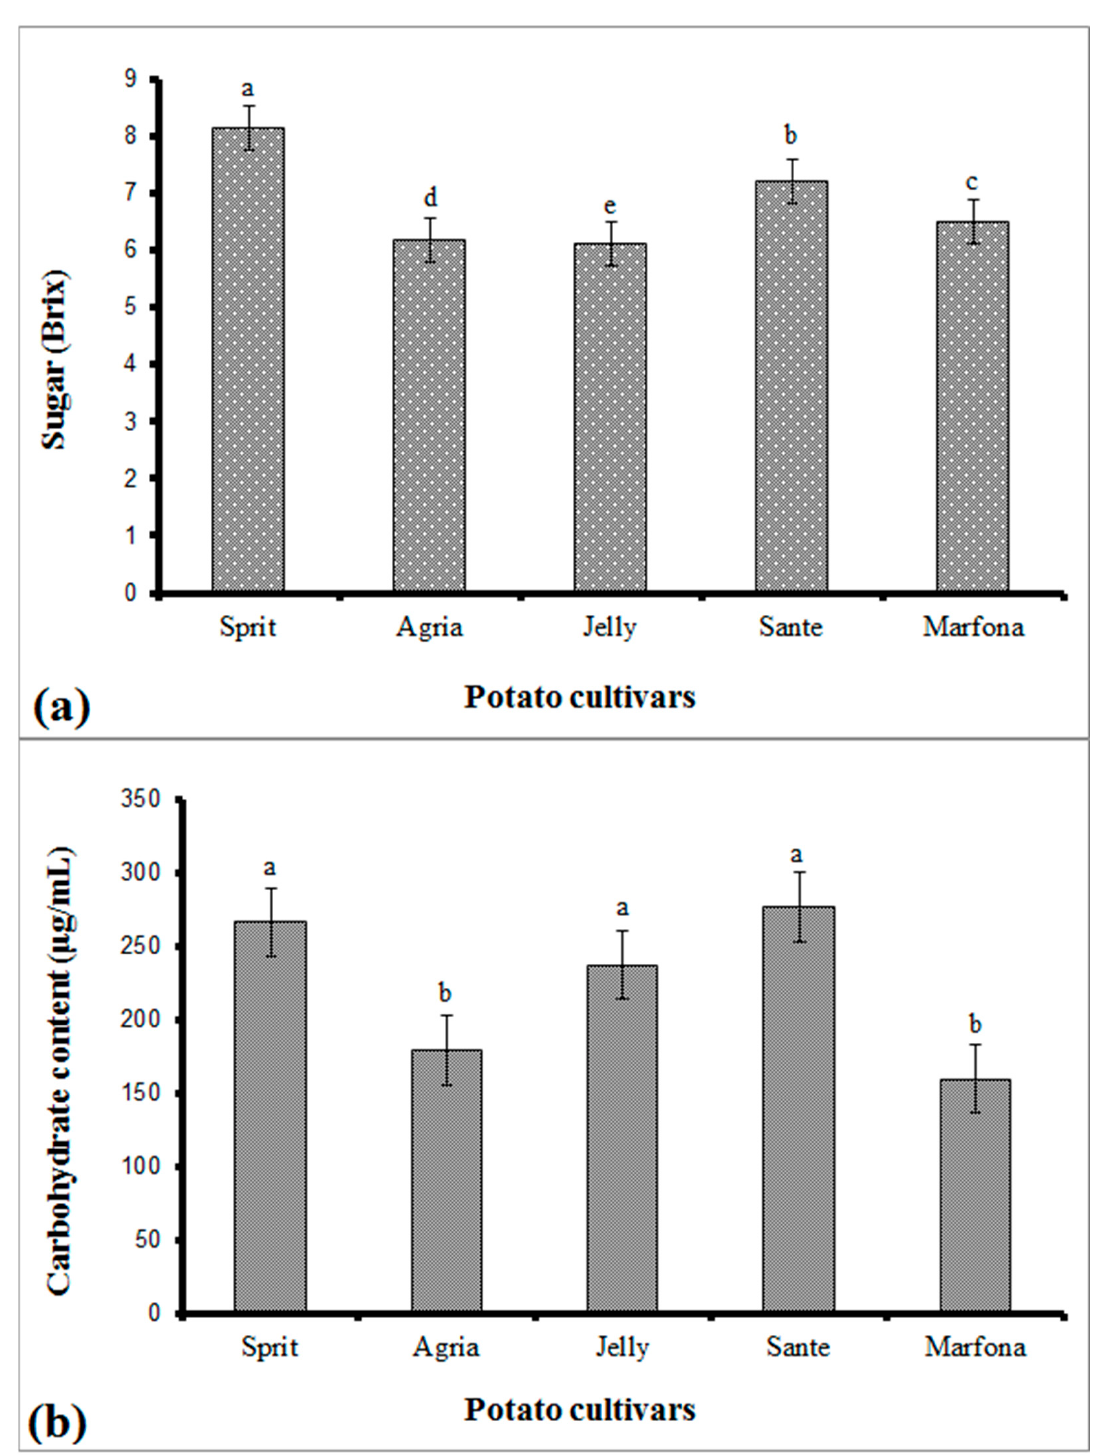
Figure 3. Result of Duncan mean comparison test for the ( a ) sugar content and ( b ) carbohydrate of potato cultivars ( α = 0.010). The letters a, b, c, d, e describe significant differences between the obtained means. Means with the same letters do not differ significantly.